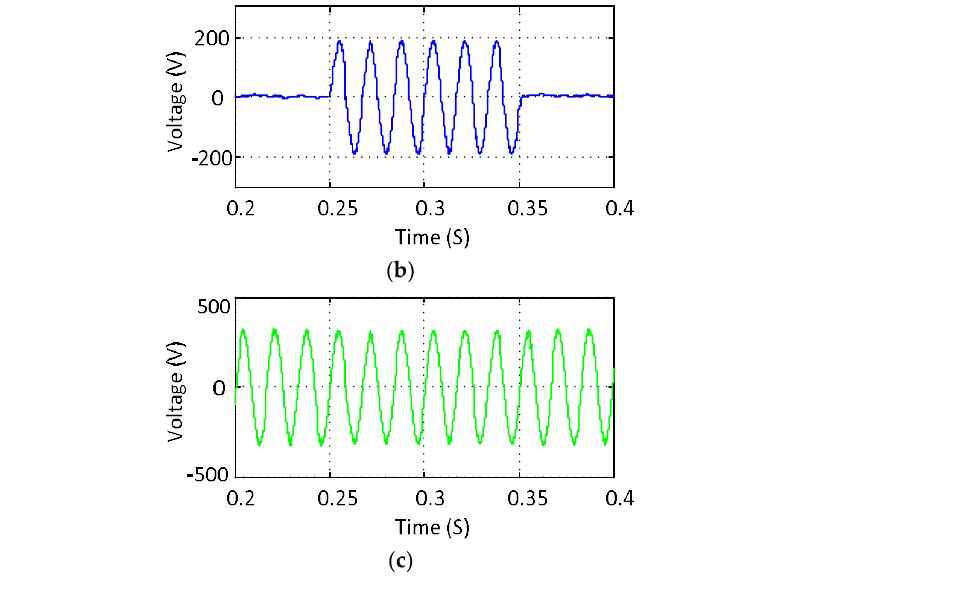
Figure 15. Simulation results of the proposed DVR at 60% voltage sag compensation: ( a ) line voltage, ( b ) output voltage of the converter, ( c ) load voltage.